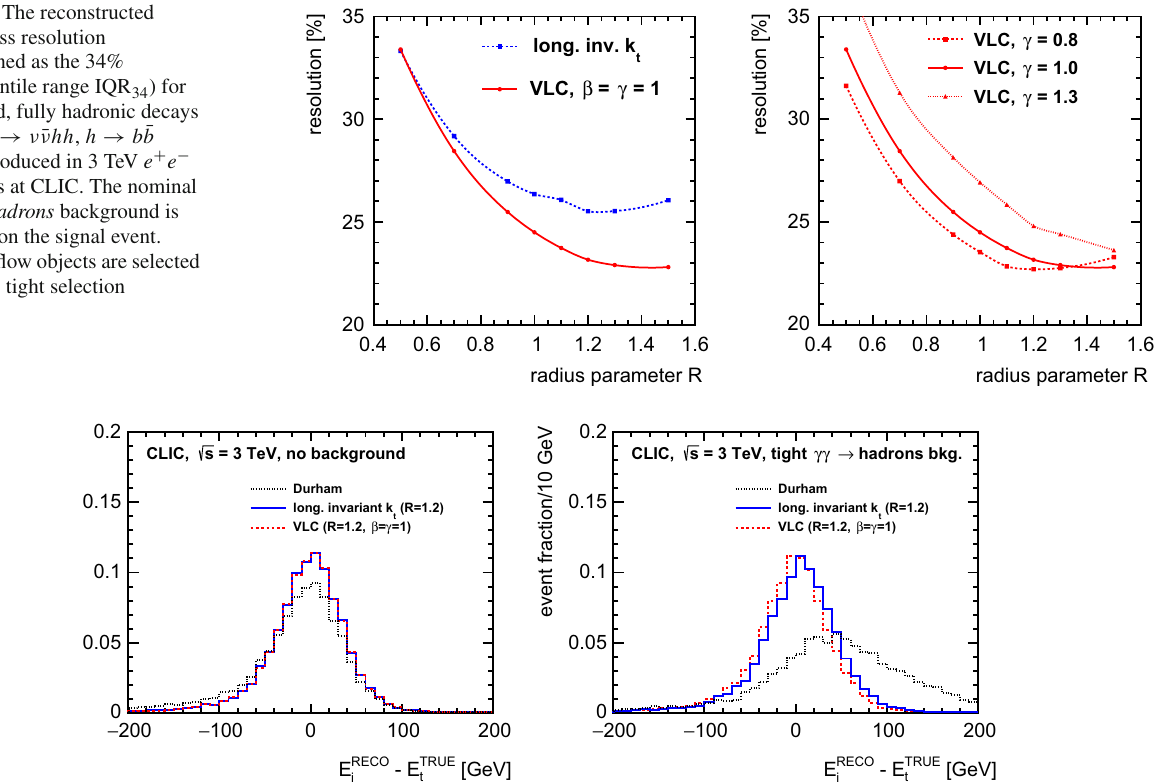
Fig. 13 The jet energy residuals (reconstructed minus true energy) for fully hadronic decays of t ¯ t events at a 3 TeV CLIC. No backgrounds are added in the left plot. In the right plot 60 bunch crossings of γγ →